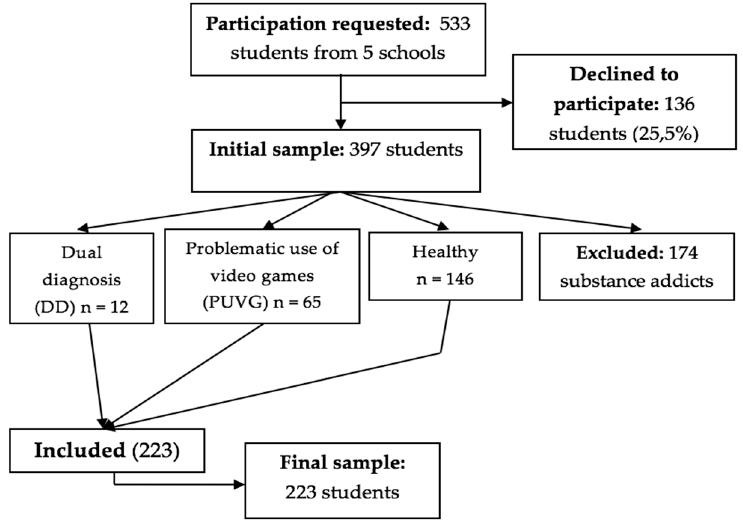
Figure 1. Sampling